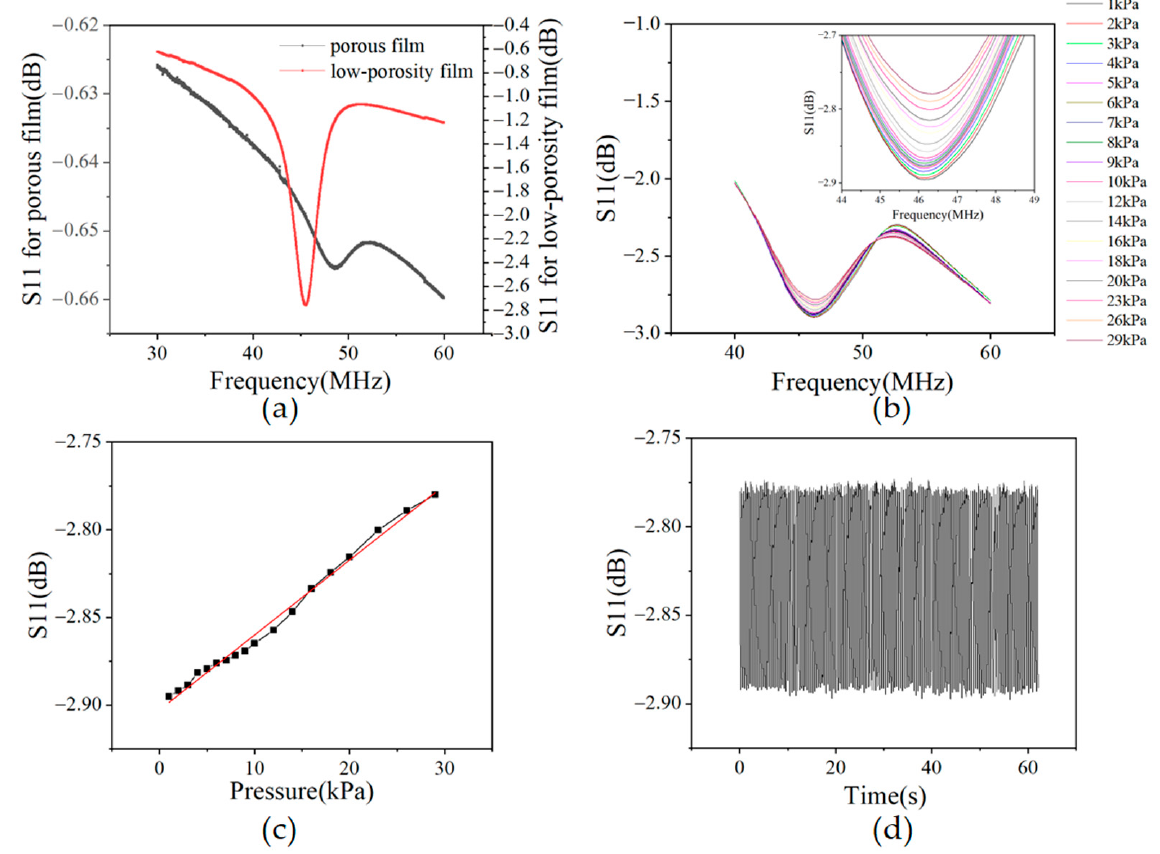
Figure 5. ( a ) Measured S 11 of FBARs based on porous and low-porosity P(VDF-TrFE) films; ( b ) S 11 of the device under different pressures; ( c ) the peak amplitude of S 11 in response to pressure variation; ( d ) S 11 peak amplitude response under cyclic pressure from 0 to 30 kPa for 150 cycles.